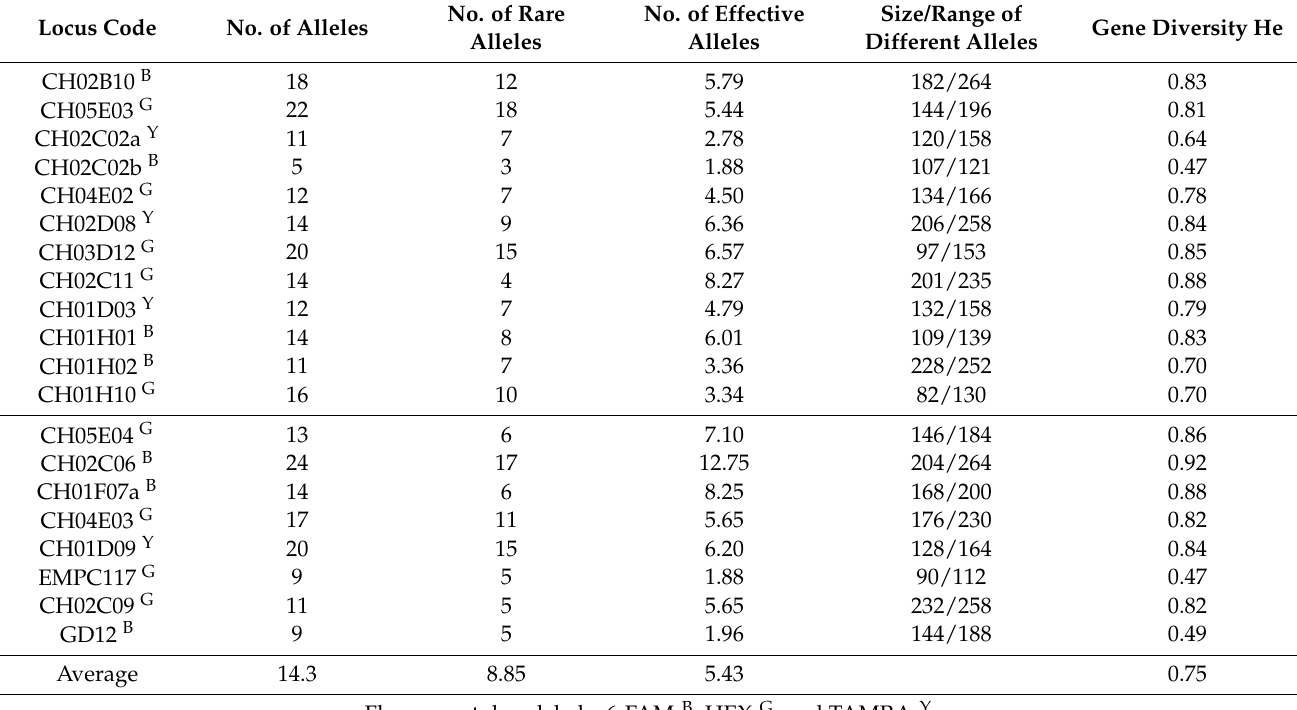
Table 2. Number of detected alleles, number of rare alleles (frequency < 0.05), number of effective alleles, allele size range, gene diversity calculated for 171 apple accessions maintained in the apple heritage cultivar collection Ullensvang,